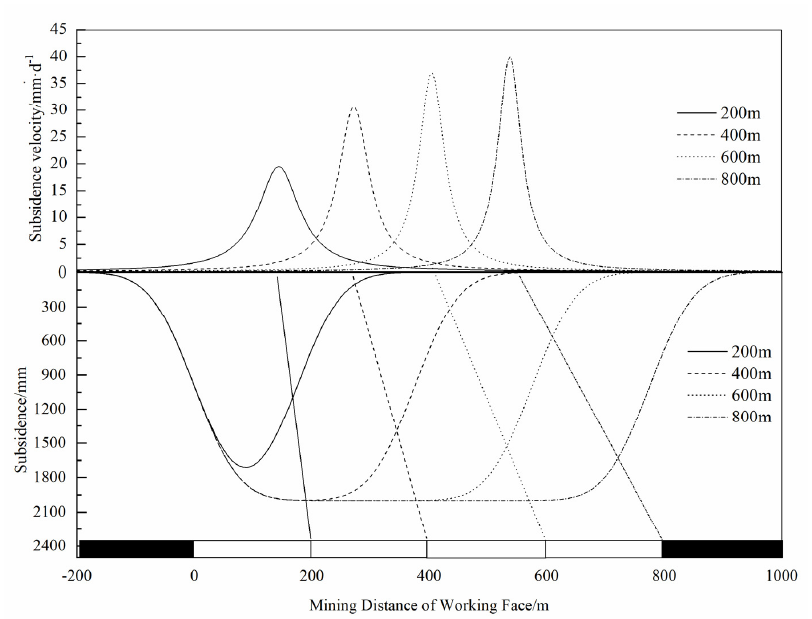
Figure 12. Surface subsidence and subsidence velocity relative locations during mining.